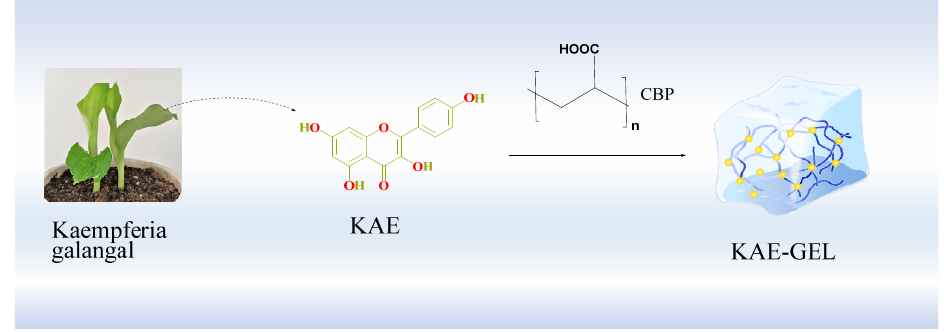
Figure 1. Preparation process of